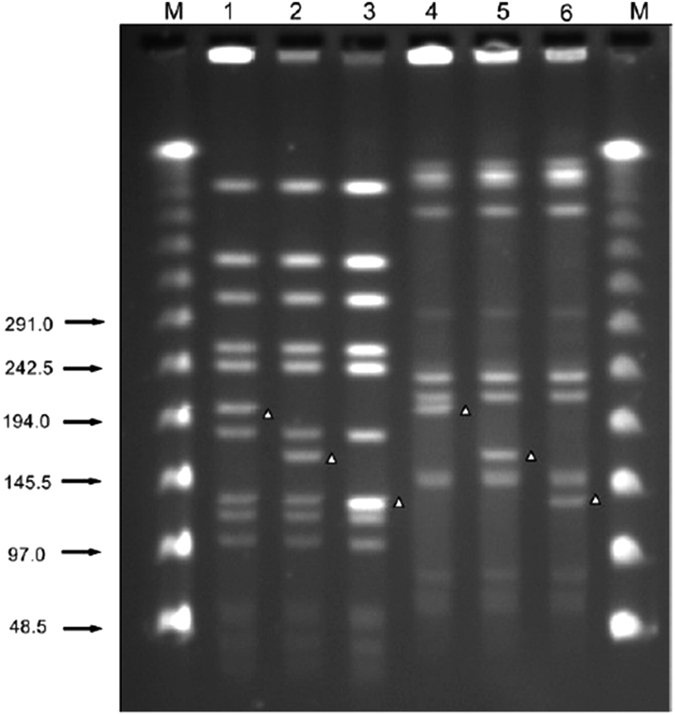
PFGE analysis of strain 3503-1 and their induced strains.The PFGE DNA ladder is shown. Lanes 1 and 4 = strain 3503-1. Lanes 2 and 5 = strain 3503VR6. Lanes 4 and 6 = strain 3503VR10. Lanes 1–3 = DNA digested by SmaI. Lanes 3–6 = DNA digested by RsrII.